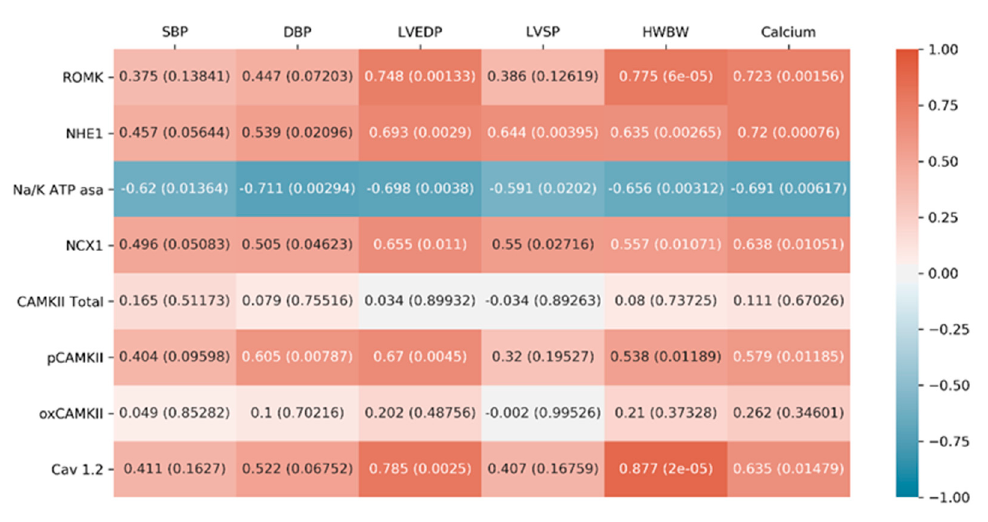
Figure 5. Correlations between cardiac function parameters and ionic exchangers proteins heat map. Systolic blood pressure (SBP), diastolic blood pressure (DBP), left ventricular end diastolic pressure (LVEDP), left ventricular systolic pressure (LVSP), body weight (BW), heart weight (HW), renal outer medullary potassium channel (ROMK), sodium–hydrogen exchanger type 1 (NHE1), Na+/K+ ATPase pump (NKA), sodium-calcium exchanger type 1 (NCX1), calcium/calmodulin-dependent protein kinase II (CaMKII), phosphorylation in threonine 286 CAMKII (pCaMKII), oxidation in methionines 281 and 282 CAMKII (oxCAMKII) and L-type voltage-dependent calcium channel (Cav1.2)